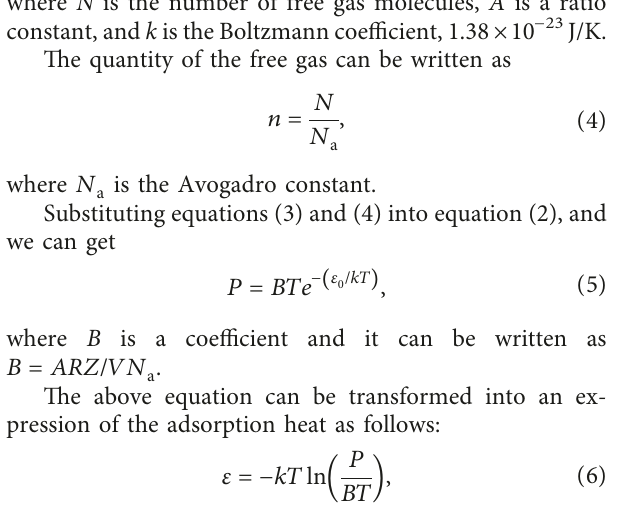
free gas content at different temperatures are shown in Figure 3; as can be seen, for each equilibrium pressure curve with different initial free gas content, the equilibrium